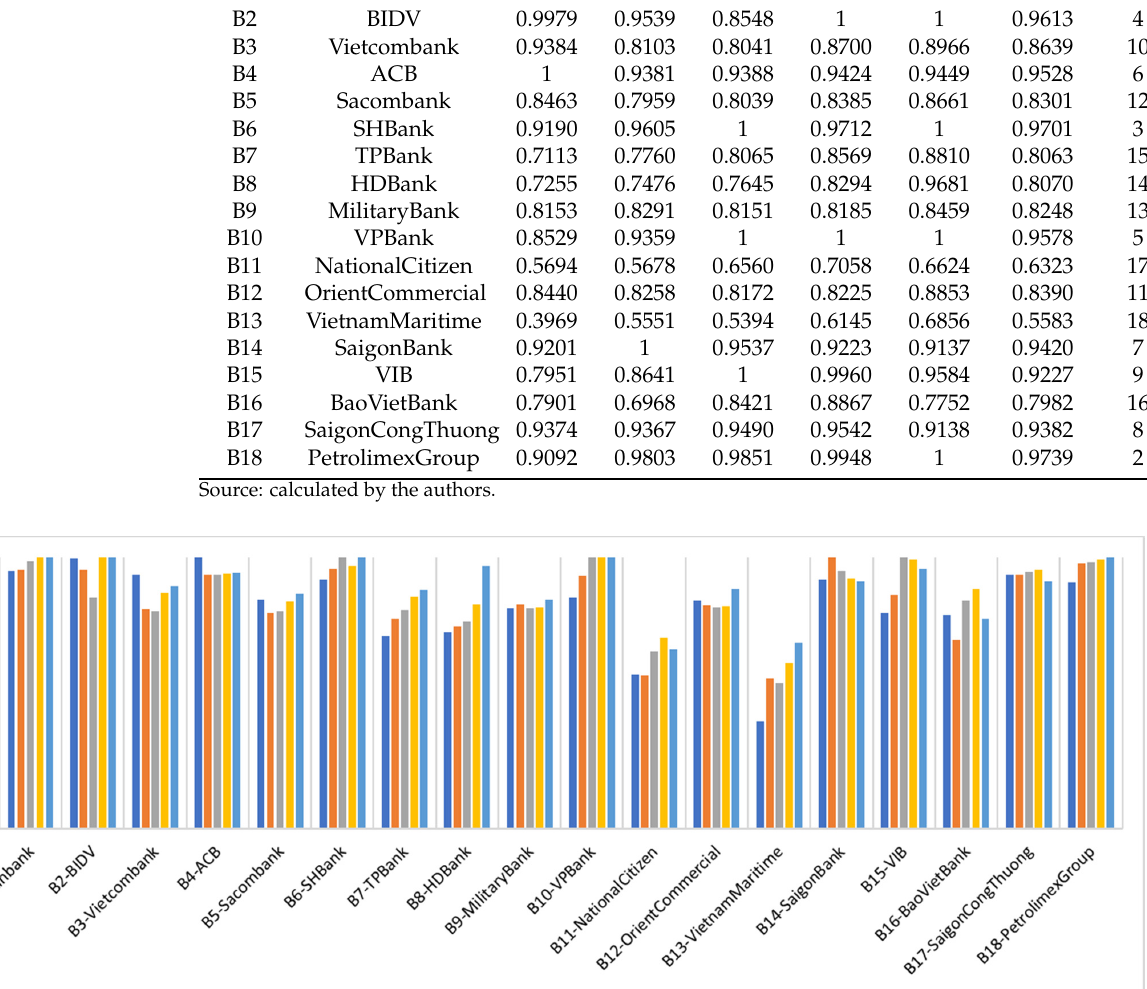
Table 9. The Window results for a 3-year period.